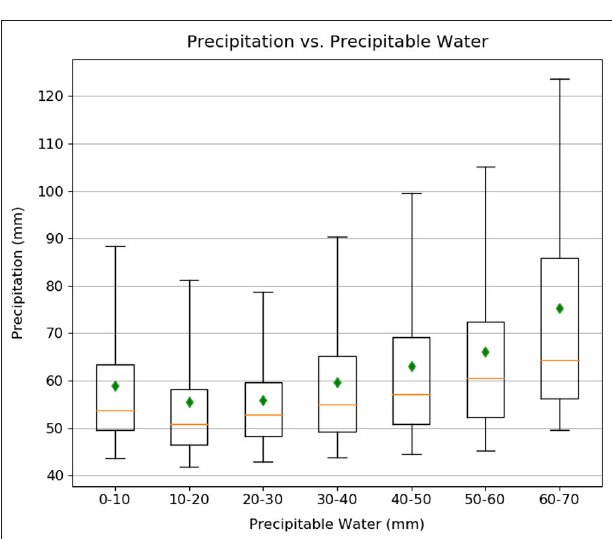
FIGURE 12 | Boxplot distributions for the 1-yr, 1-dy partial duration series events of precipitation event amount vs. the same-day 3-h maximum PW sorted into 10mm interval bins. Boxplots display mean (green diamonds), median (orange horizontal lines), 25th and 75th percentiles (box limits), and 5th and 95th percentiles